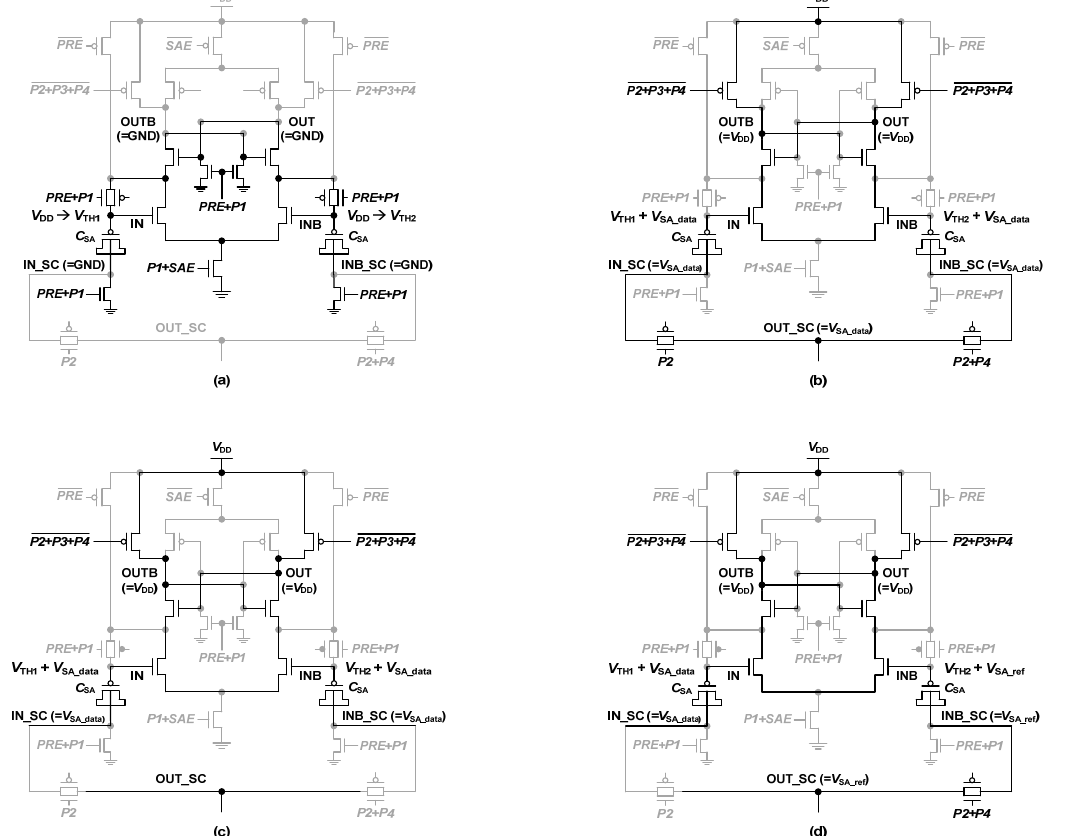
Figure 6. Operations of the OCZS-SA in ( a ) phase 1, ( b ) phase 2, ( c ) phase 3, and ( d ) phase 4.